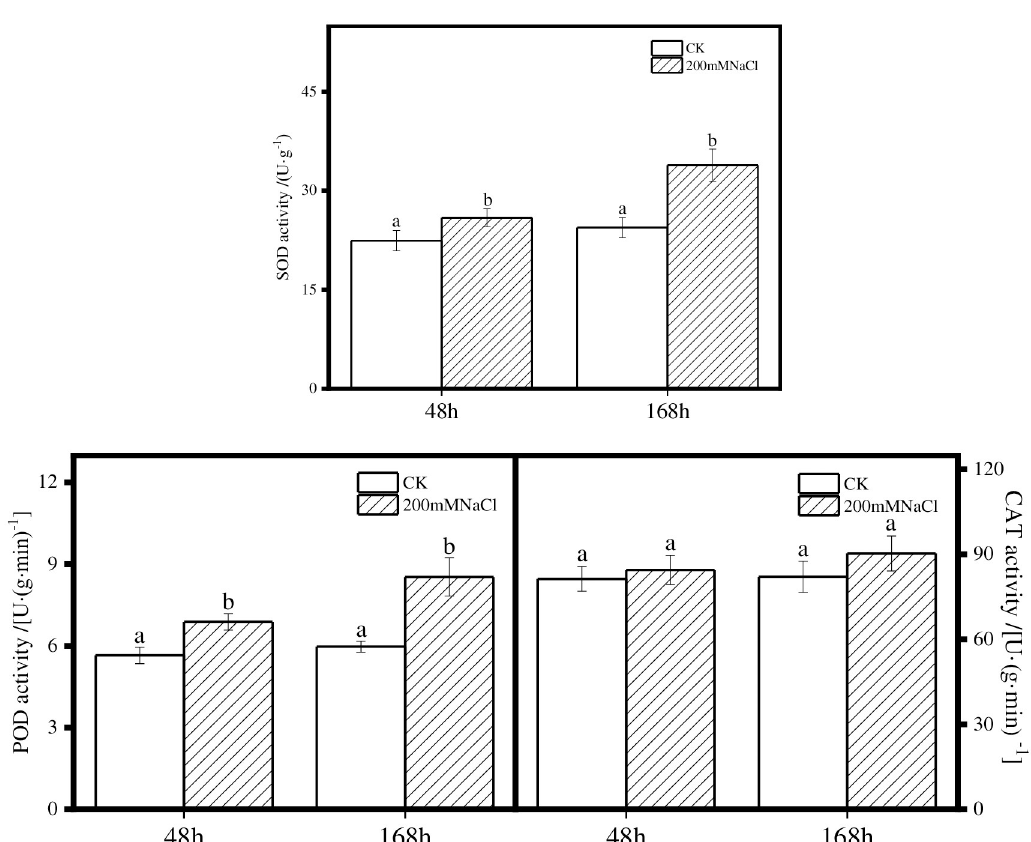
Fig 2. Changes of SOD, POD and CAT enzyme activities in leaves of T . ramosissima under salt stress. (Note: The different letters indicate significant differences at the p value < 0.05. The graph illustrates the changes of enzyme activities in SOD, POD and CAT compared with CK group at 48h and 168h after 200mM NaCl treatment).